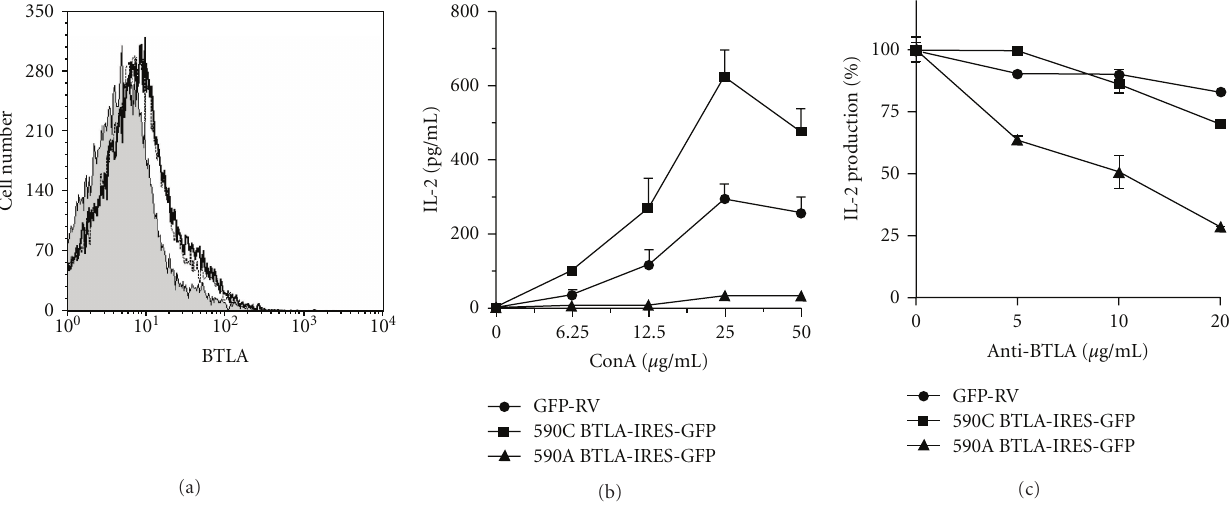
Figure 2: Loss of inhibitory function of 590C BTLA on ConA- and anti-CD3 Ab-induced IL-2 production in Jurkat T cells. (a) FACS analysis of BTLA expression in stable transfectants of Jurkat T cells with the retrovirus of 590A BTLA-IRES-GFP (solid line), 590C BTLA-IRES-GFP (dotted line), or GFP-RV (a negative control; shaded histogram). Both of transfectants express BTLA at similar levels. (b) ConA-induced IL-2 production from Jurkat T cells expressing 590A BTLA or 590C BTLA. Jurkat T cells expressing 590A BTLA or 590C BTLA (5 × 10 5 cells) were cocultured with 2 × 10 5 of HVEM-expressing CHO cells in the presence of various concentrations of concanavalin A (ConA). Twenty-four hours later, IL-2 levels in the supernatants were measured by ELISA. Representative data from three independent experiments are shown. (c) Anti-CD3 Ab-induced IL-2 production from Jurkat T cells expressing 590A BTLA or 590C BTLA. Jurkat T cells expressing 590A BTLA or 590C BTLA (5 × 10 5 cells) were stimulated with immobilized anti-CD3 Ab (0.2 μ g/ml) and various concentrations of immobilized anti- BTLA Ab (MIH26) (0–20 μ g/ml) in the presence of anti-CD28 Ab (1 μ g/ml). Twenty-four hours later, IL-2 levels in the supernatants were determined by ELISA. Representative data of the percent IL-2 production from three independent experiments are